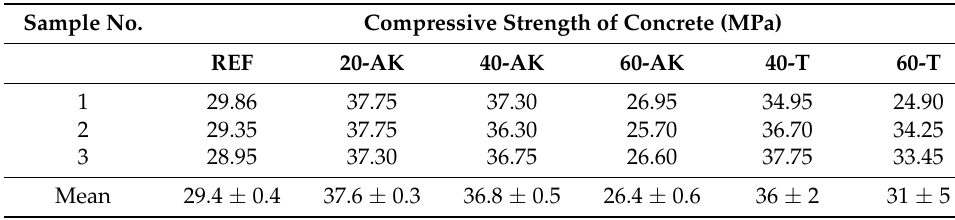
Table 9. Results of compressive tests on reference and aged concrete cylinders.